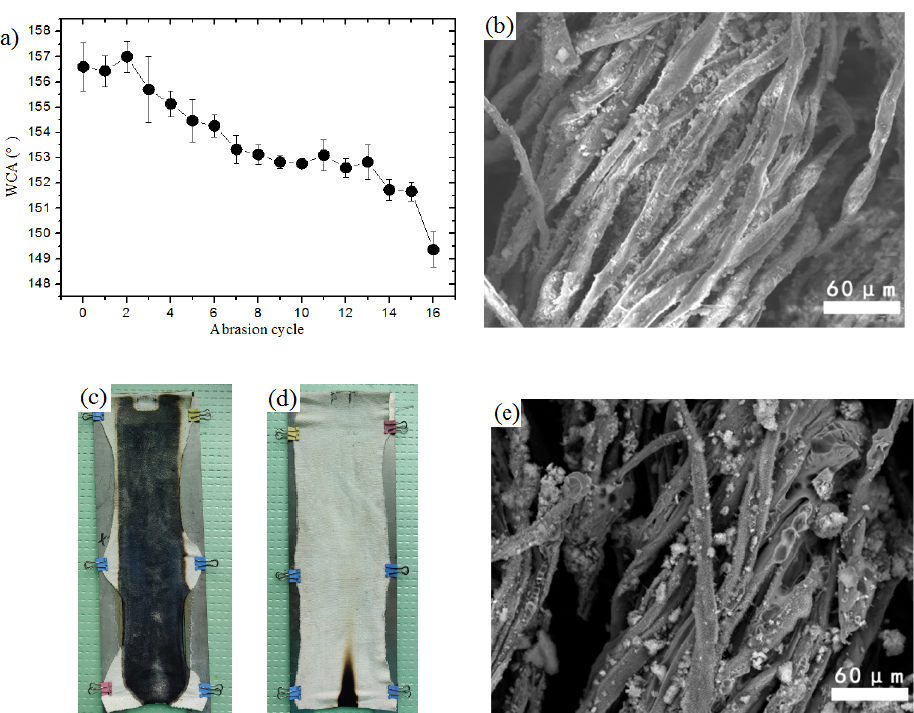
Figure 8. ( a ) Change of WCA of the BAPC cotton fabric with abrasion cycles, ( b ) SEM image of BAPC cotton fabric after abrasion, burning figures of ( c ) PC and ( d ) BAPC cotton fabric after abrasion and ( e ) SEM image of and burnt BAPC cotton fabric after abrasion.